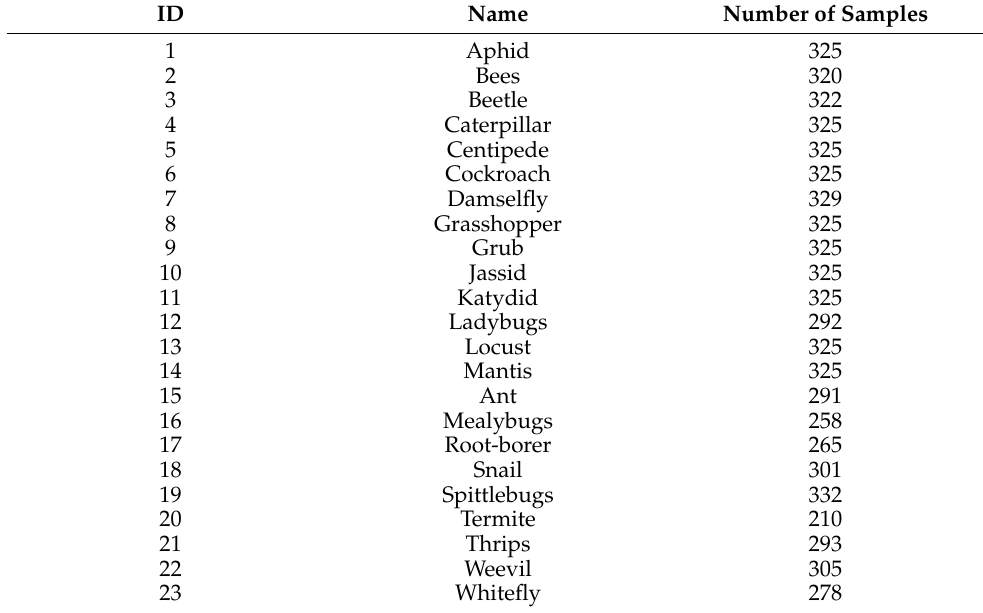
Table 1. Details of the collected IP-23 images dataset.